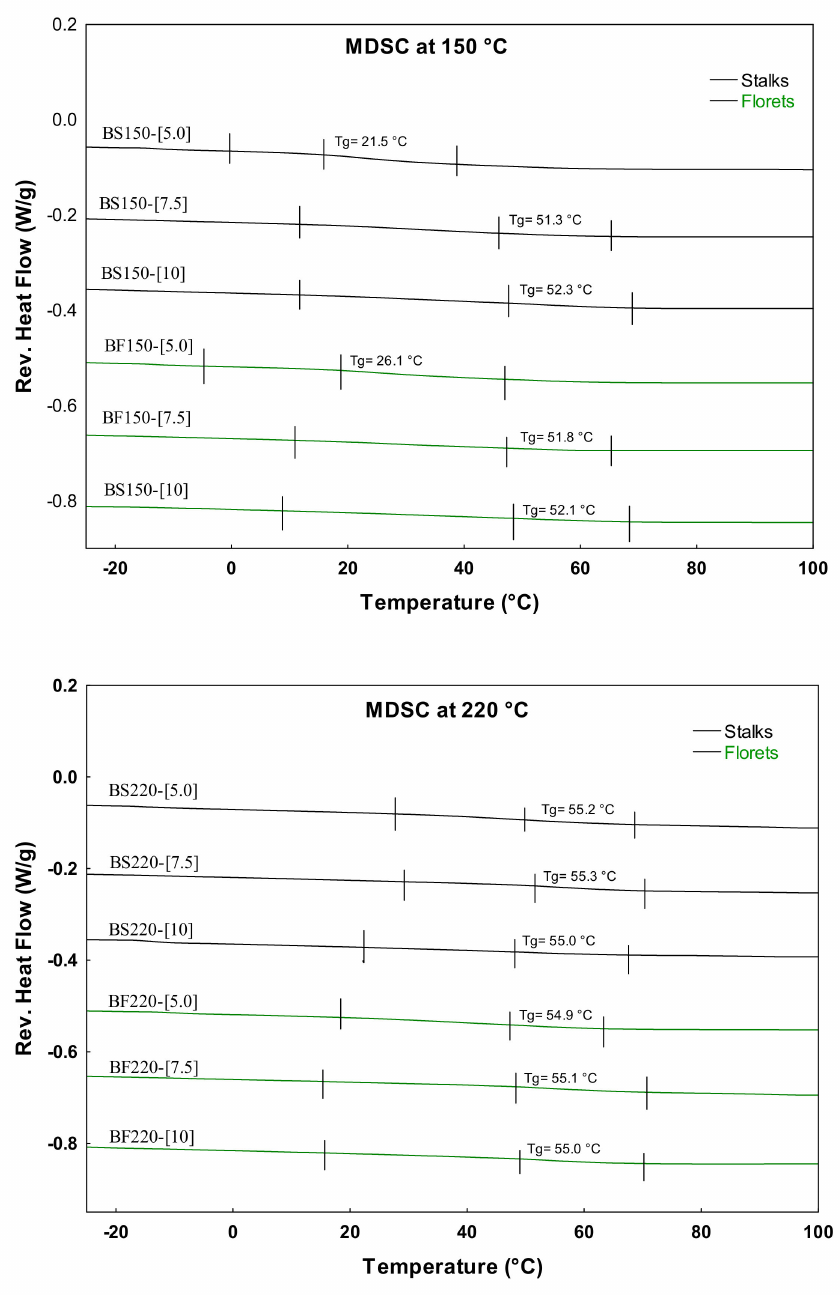
Figure 3. Modulated differential scanning calorimetry (MDSC) thermograms for determining the Tg of the BJ − MX powders. Tg was determined as the change in the slope of the curve. The Tg values for the samples dried at 150 ◦ C were about 51 ◦ C, while for those samples dried at 220 ◦ C, they were about 55 ◦ C. Based on these values, both systems may be stable when storage is at temperatures below the Tg and relatively low atmospheric humidity. From the two systems, the powders prepared at 220 ◦ C may present higher stability. However, the samples identified as BS150-[5.0] and BF150-[5.0] presented Tg values close to 25 ◦ C. From these results, some valuable storage information may be inferred. For example, these two powder samples must be stored at temperatures below 25 ◦ C, otherwise the powder may suffer a solid-state change from the amorphous state into the rubber state. In the rubber state, the microencapsulated compounds may be released from the powder particles, losing their antioxidant